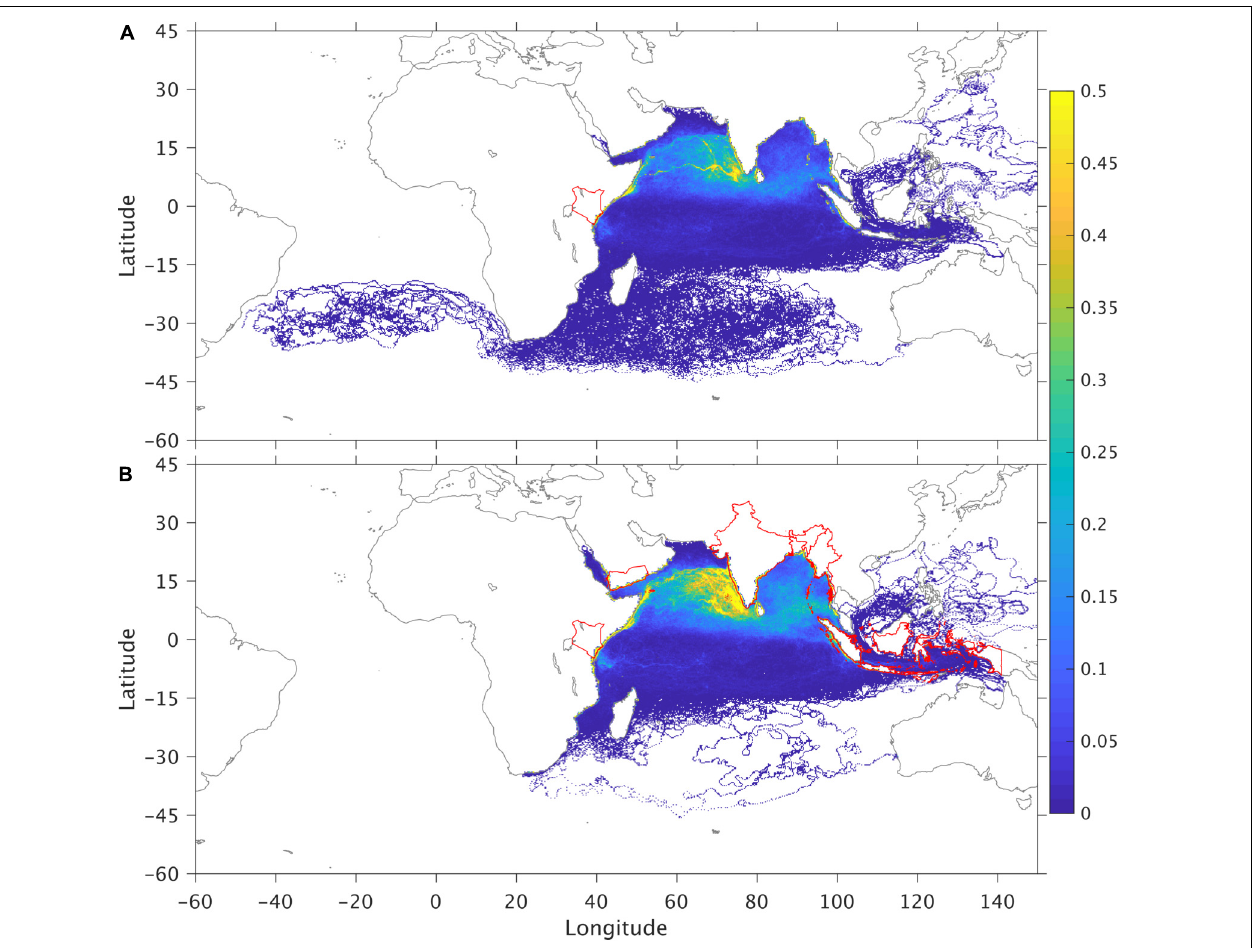
FIGURE 7 | Time-averaged concentration (in kg/km 2 ) of the mismanaged plastic waste that are released from Kenya and that remains in the ocean (Panel A ) or is beached on another country’s coast (Panel B ) at the end of the 2019. Red lines outline the border of Kenya in Panel A and the border of the five countries ( Table 1 ) that received the most MPW from Kenya (Kenya, India, Indonesia, Myanmar, and Yemen) in Panel B.